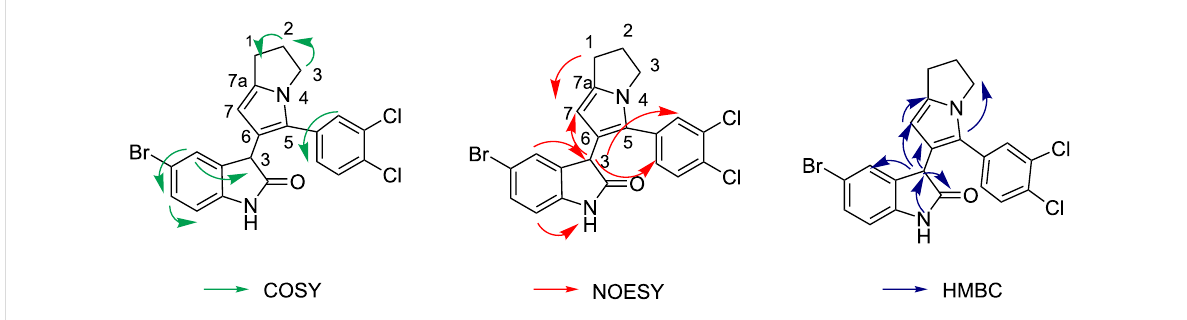
Figure 7: The selected COSY, NOESY and HMBC correlations of the signals in the 1 H and 13 C NMR spectra of compound 7a .